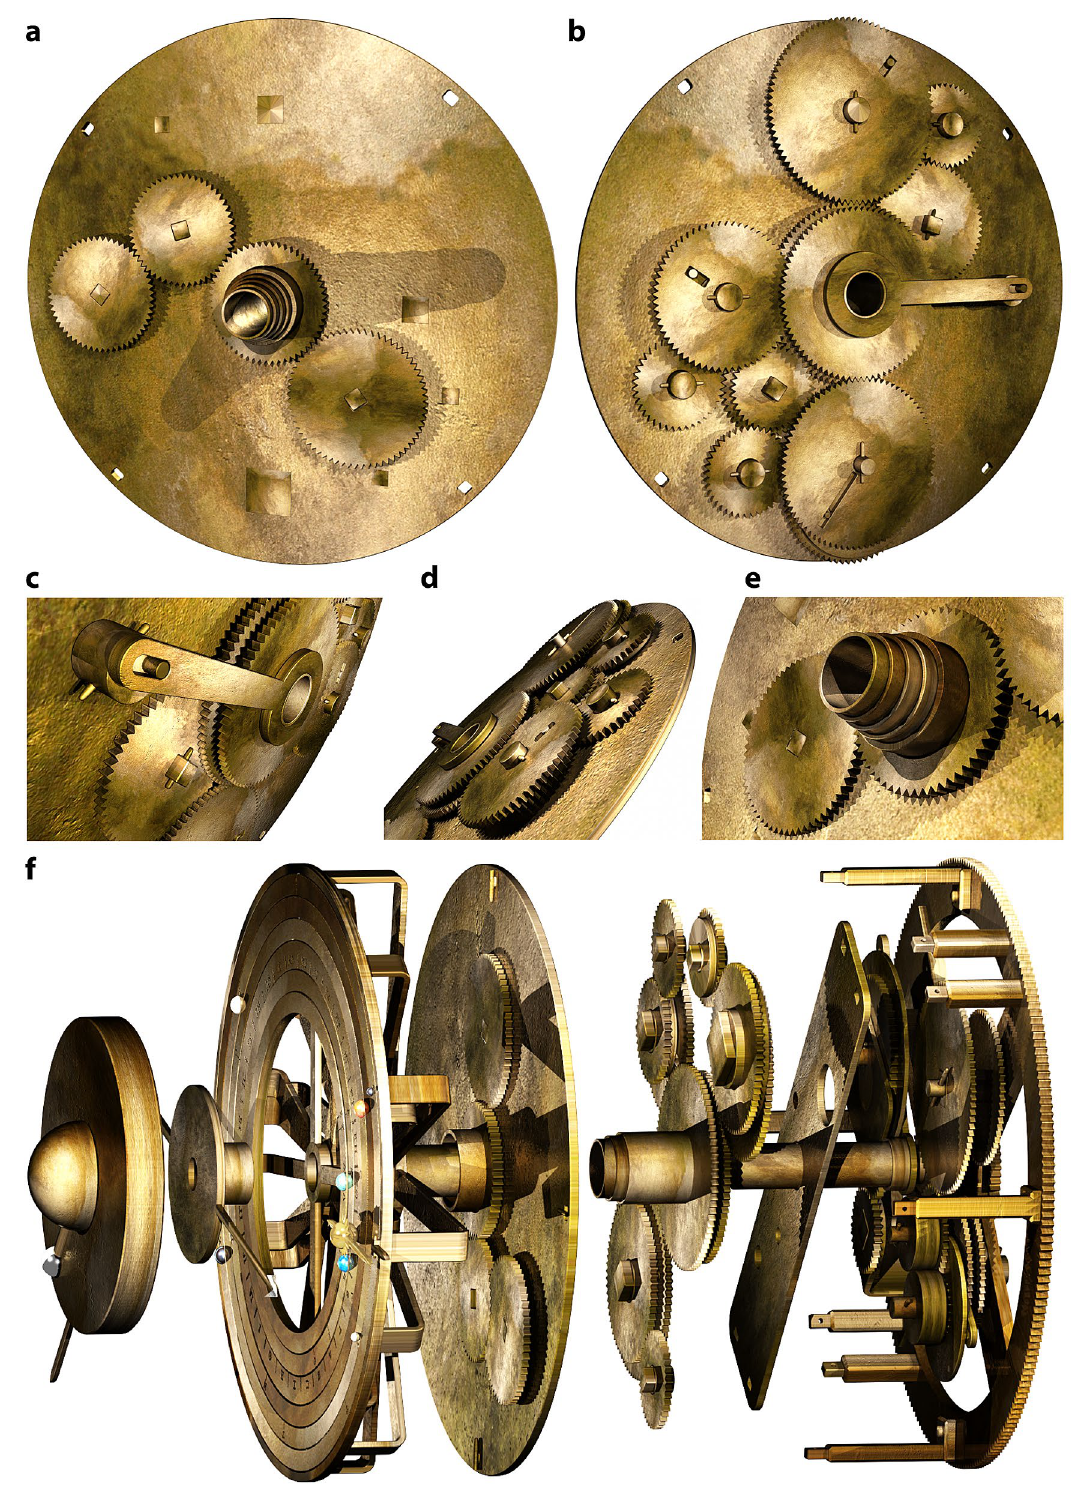
Figure 6. True Sun, Superior Planets and exploded Cosmos gearing. ( a ) The gears at the front of the CP . Centre in (a): fixed gear 56 , rivetted to a subsidiary plate (not seen). Bottom right in (a): 64 , shared between Mars and Jupiter; Top left in (a): 52 , shared between the true Sun and Saturn . Left in (a): 56 is the epicyclic gear for the true Sun gearing. ( b ) The mechanisms seen from the back of the CP . Clockwise from the top: Saturn , true Sun , Mars , Jupiter . ( c ) Close-up of true Sun mechanism. ( d ) Close-up of gears showing interleaved layers. ( e ) Close-up of output tubes. ( f ) Exploded model of Cosmos gearing. From right to left : b1 , mean Sun , Nodes , Mercury , Venus ; true Sun and superior planets gearing; CP and shared gears ; Ring Display ; Dragon Hand ; Moon position and phase mechanism